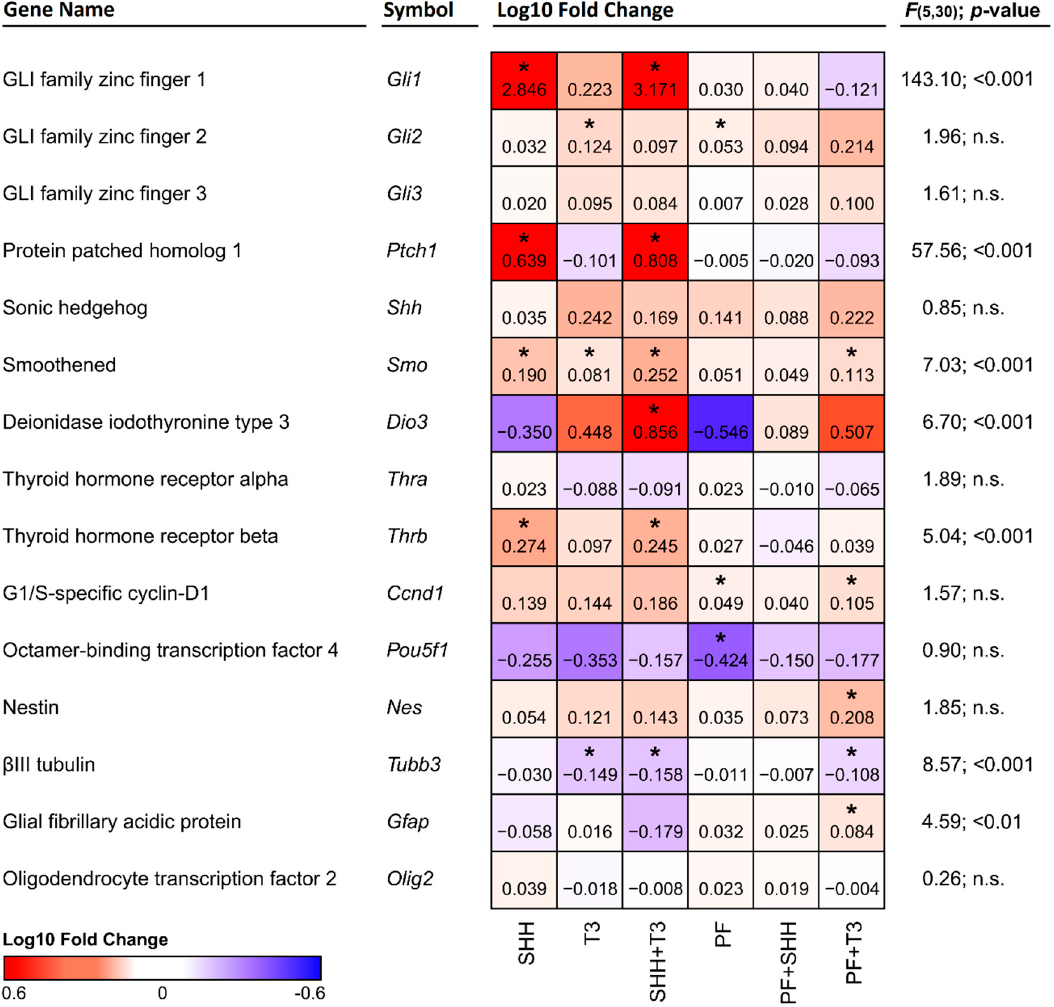
Figure 3. Heatmap depicting changes in the expression of individual genes relative to control cells. Red denotes an increase and blue denotes a decrease in expression. The numbers in the individual tiles represent average log10 fold change relative to control cells, and the asterisks indicate statistical significance (* p < 0.05). F and p show statistical significance of the relative effect of the treatment factor (permutation one-way ANOVA).